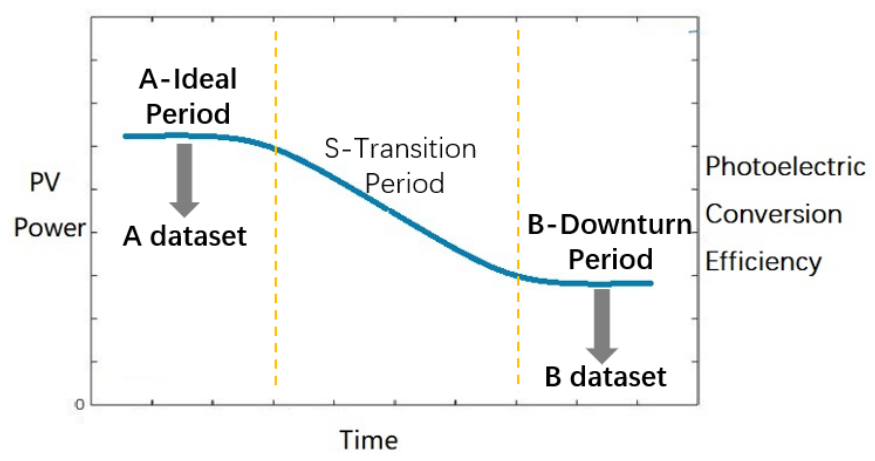
Figure 2. Three typical states of PV power.